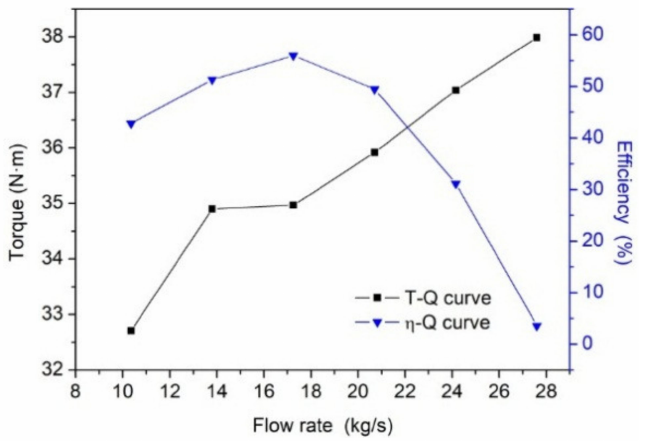
Figure 13. Pump hydraulic performance in terms of torque and efficiency.